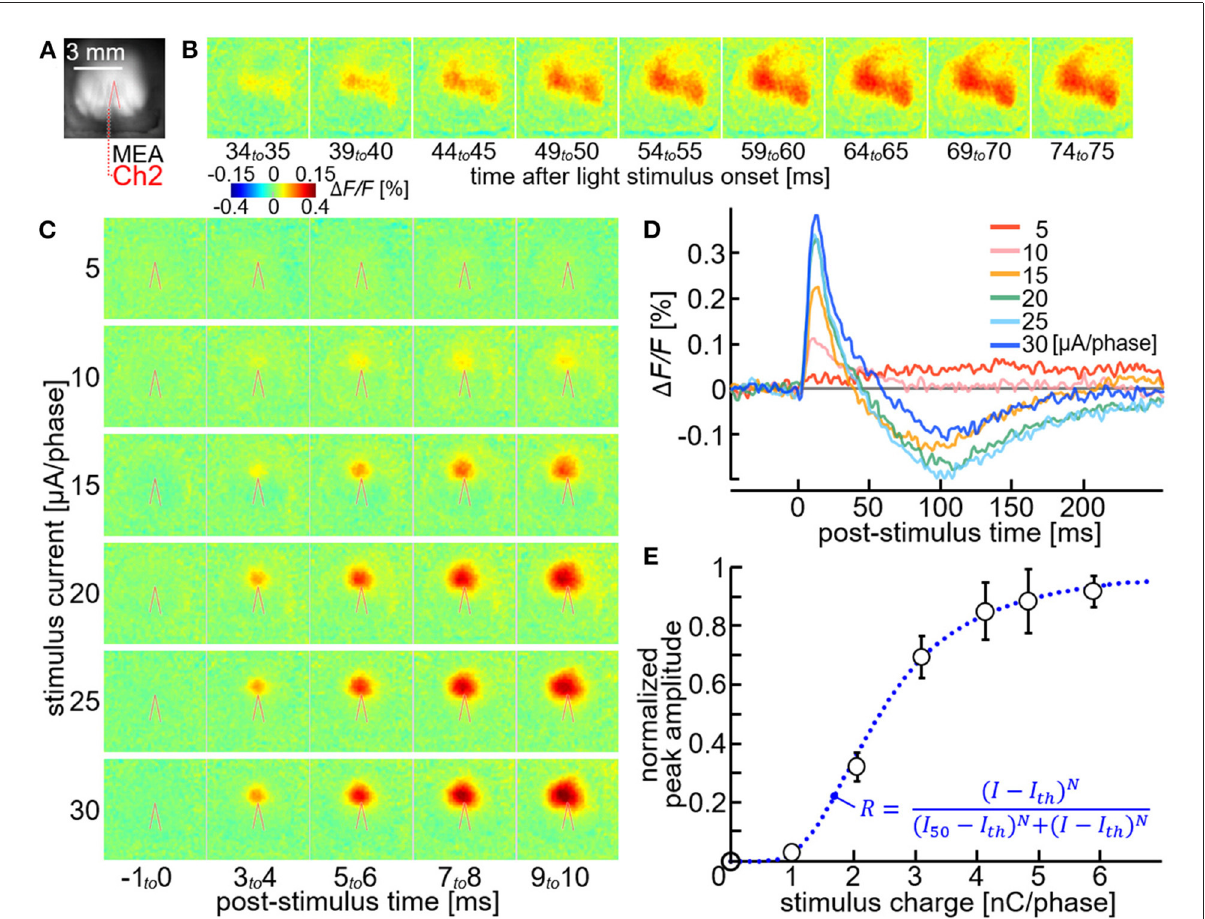
FIGURE6 Neural excitations with using the stimulation module. (A) VSD fluorescence image of the cortex. Red line indicates the outline of shadow of the stimulating electrode shaft. (B,C) Pseudo-color time-lapse images of the rational VSD fluorescence change ( 1 F/F ) induced by the light stimulus (B) or the microstimulation with different current amplitudes (C) . (D) Time courses of the 1 F/F measured near the stimulating electrode tip. Different colors represent different stimulus amplitudes. (E) Normalized peak response amplitude plotted against the stimulus charge. The data were obtained with a total of 8 electrodes in 6 rats. The plot and error bars indicate the mean ± s.e.m. for the 8 data sets. The smooth line indicates the fitted curve of a modified Hill function